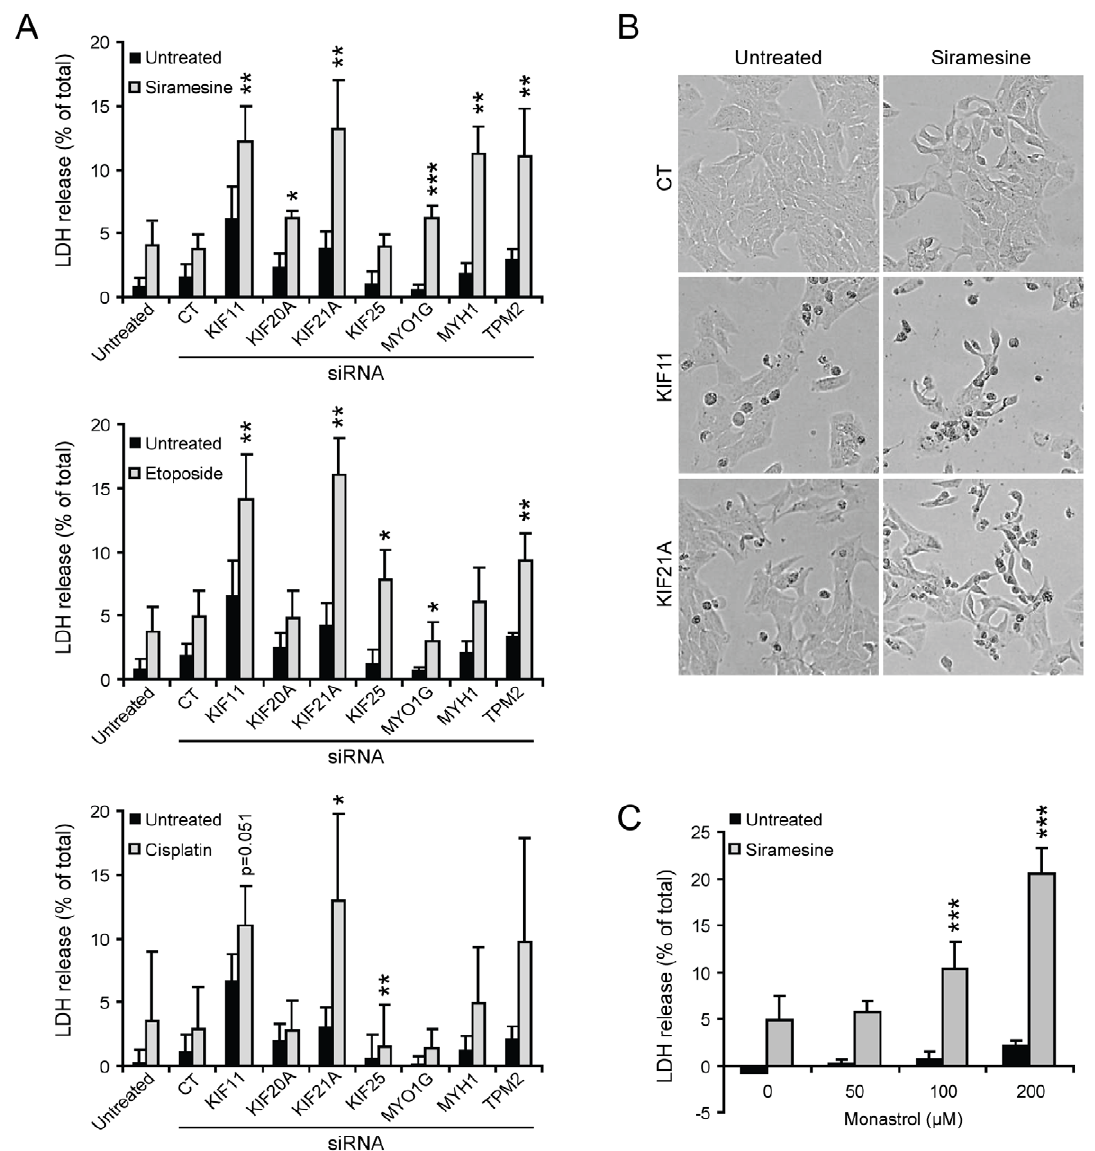
Figure 5. Sensitization to lysosome-disrupting drugs by the identified siRNAs and monastrol. (A, B) MCF7 cells were left untreated, treated with Oligofectamine (Oligo) or transfected with control siRNA or indicated siRNA pools (3 6 6.67 nM). After 48 h, cells were left untreated or treated with 2 m M siramesine ( top ), 50 m M etoposide ( middle ) or 10 m M cisplatin ( bottom ) for additional 48 h before light microscopy pictures were taken (representative images in B) and cell death was quantified by the LDH release assay (A). (C) MCF7 cells were left untreated or treated with 2 m M siramesine together with indicated concentrations of monastrol for 72 h and cell death was quantified by the LDH release assay. Values represent means + SD of a minimum of three independent experiments. * P , 0.05, ** P , 0.01, *** P , 0.001, vs. control siRNA-transfected cells (A) or cells treated with 2 m M siramesine alone (C).